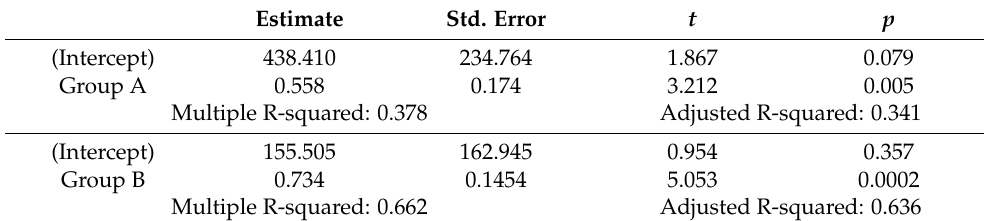
Table 3. Linear Model for PGE 2 .